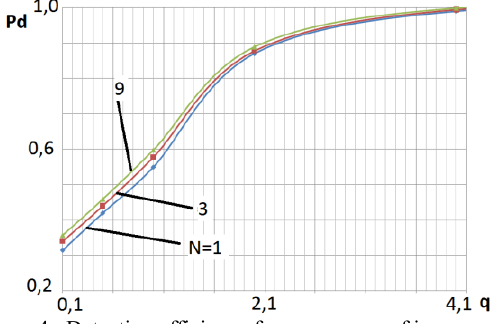
Figure 4. Detection efficiency for a sequence of images with different number of